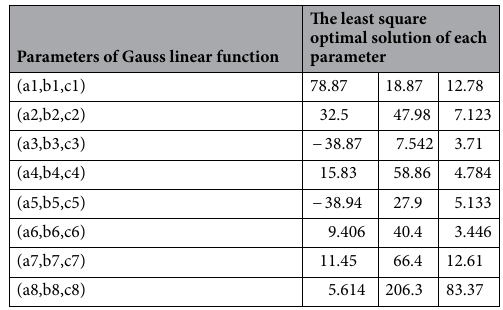
Table 5. Parameters determined by Gauss multi-peaks method with 95% confidence bounds (C 1 –C 2 –D 2 ).